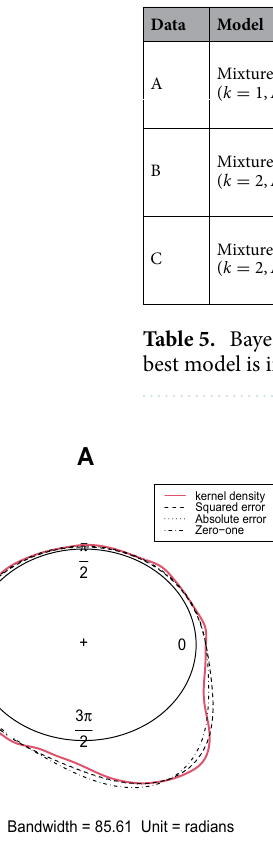
Figure 9. Kernel density plots of datasets and fitted curves based on Bayes